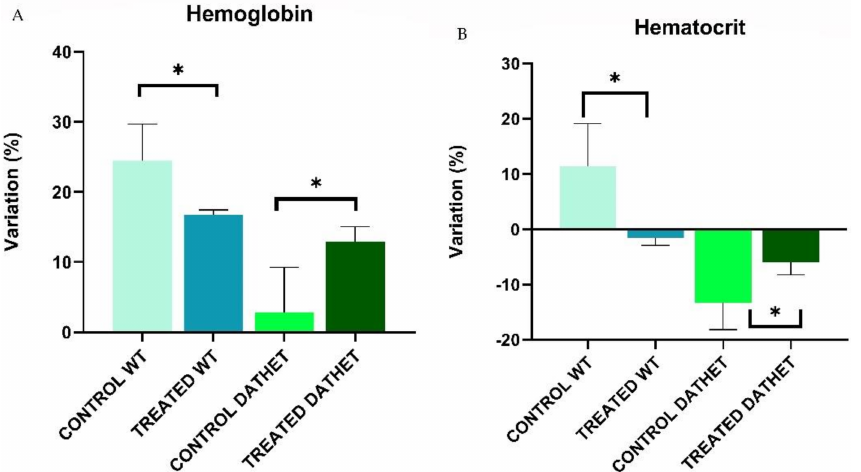
Figure 6. ( A ) Percentage variation of Hemoglobin (between end of treatment and baseline) in control rats and treated rats. The bar graph shows that percentage variation of hemoglobin was reduced in WT-treated subjects than water control subjects; DATHET-treated subjects showed a higher percentage variation compared to water control subjects. ( B ) Percentage variation of Hematocrit in control rats and treated rats. The bar graph shows that WT-treated subjects exhibited a more negative percentage variation than water control subjects; DATHET-treated subjects showed a reduced negative percentage variation compared to water control subjects. Error bars represents standard errors of mean, SEM. * p < 0.05 compared to control